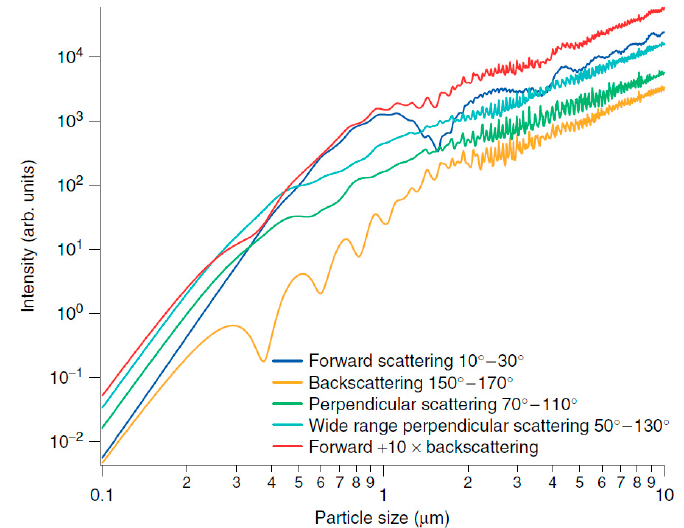
Figure 5. Calculated calibration curves for different scattering angles and integration ranges for polystyrene latex: in the case of forward and back-scattering, the relationship between size and scattering intensity in some size intervals, namely the 0.4–1 μ m range for back-scattering and the 1–3 μ m range for forward scattering, is not uniform. In the case of perpendicular scattering, shorter oscillations are observed in the range of 2–5 μ m; this latter geometry is preferable both for its dimensional distribution and because it has less dependence on the refractive index of the particles (image reprinted with permission of [59] provided by Wiley—VHC Publisher).